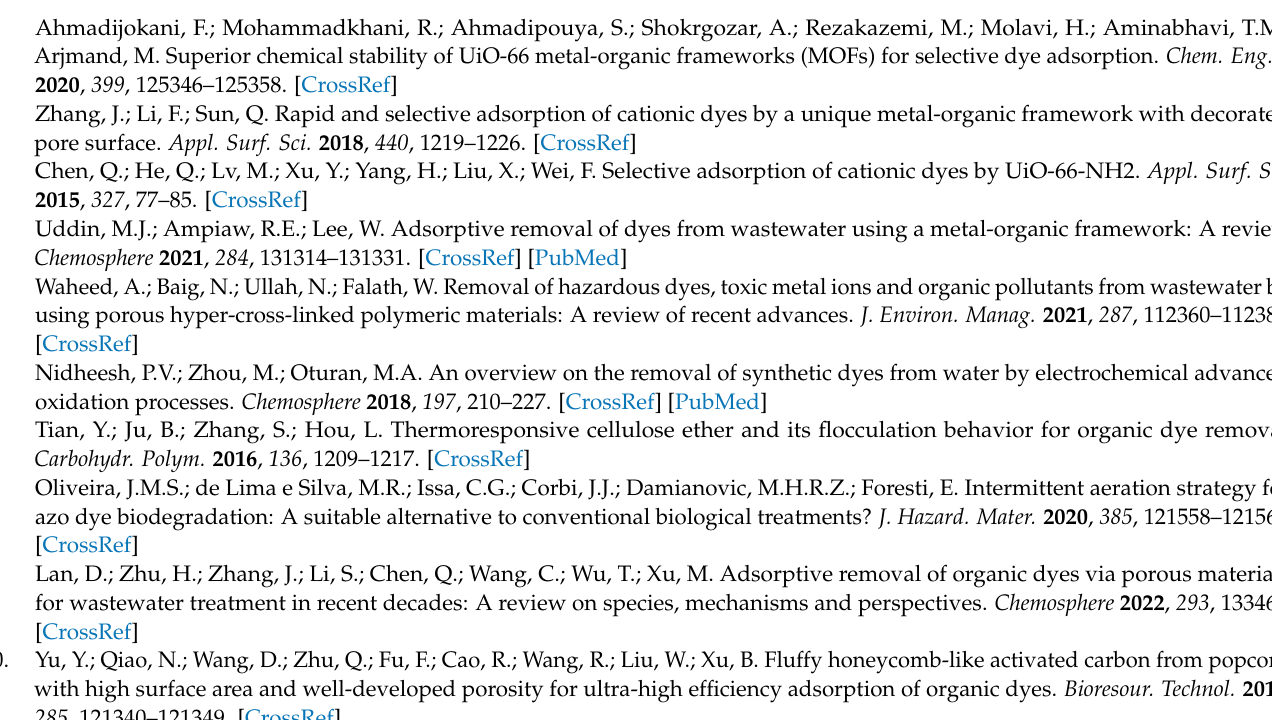
UiO-66 at different time intervals; Figure S6: The (a, b) pseudo-second-order kinetics plots and (c, d) intraparticle diffusion kinetics plots fittings of ST and MB adsorption on UiO-66 and Al 0.3 Zr 0.7 -UiO-66; Figure S7: The (a, b) Langmuir model and (c, d) Freundlich model isotherm fittings for ST adsorption on Al 0.3 Zr 0.7 -UiO-66 and UiO-66; Figure S8: The (a, b) Langmuir model and (c, d) Freundlich model isotherm fittings for MB adsorption on Al 0.3 Zr 0.7 -UiO-66 and UiO-66; Figure S9: The calculated PC of UiO-66 and Al 0.3 Zr 0.7 -UiO-66 as a function of initial dye concentrations. (a) ST, (b) MB dyes; Figure S10: FTIR spectra of Al 0.3 Zr 0.7 -UiO-66 before and after adsorption; Figure S11: The adsorption amount of Al 0.3 Zr 0.7 -UiO-66 on (a) ST and (b) MB varied with pHs; Figure S12: Schematic diagram of the proposed adsorption mechanism of two dyes’, ST and MB, adsorption on Al-doped UiO-66. Table S1: EDS analysis result of Al 0.3 Zr 0.7 -UiO-66; Table S2: ICP data of Al x Zr (1-x) -UiO-66 samples.; Table S3: Comparison of organic dye adsorption capacities of Al 0.3 Zr 0.7 -UiO-66 among various adsorbents